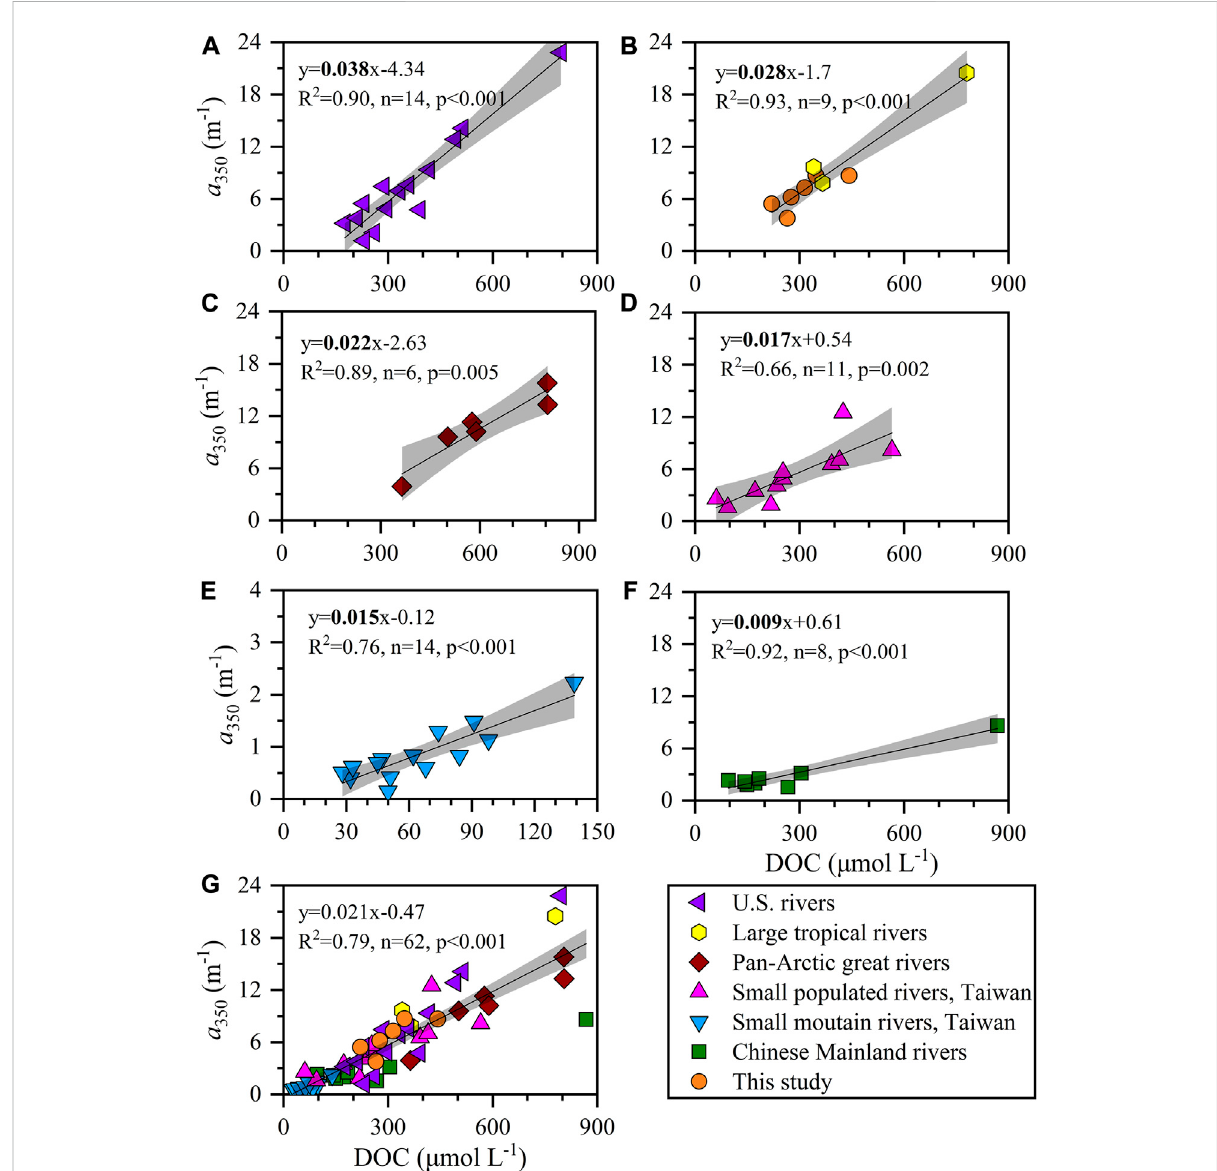
FIGURE 9 The correlations between DOC and a 350 in (A) United States rivers, (B) our study and tropical large rivers, (C) pan-Arctic great rivers, (D) small populatedrivers,TaiwanIsland, (E) smallmountainrivers,TaiwanIsland, (F) ChineseMainlandriversand (G) atotalof52riversintheglobe.Blanklines and gray shadows represent the linear fi ts and con fi dent bands (95%), respectively. Data are listed in Supplementary Table